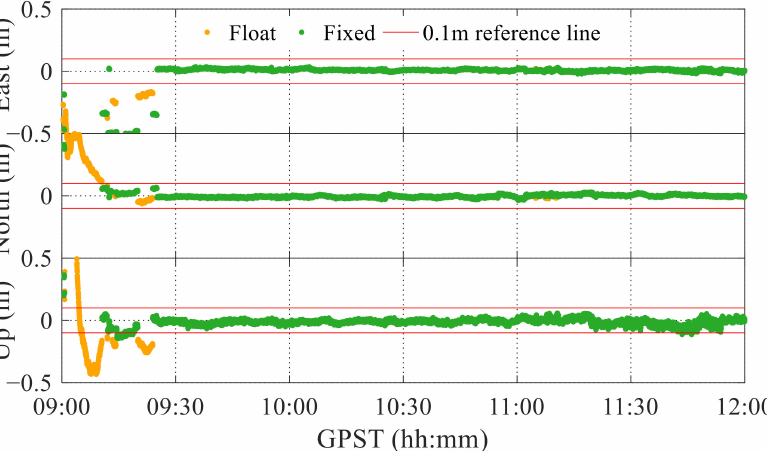
Figure 10. Fixed ambiguity solutions using fix-and-hold mode for GPS L1 + Galileo E1 observations.